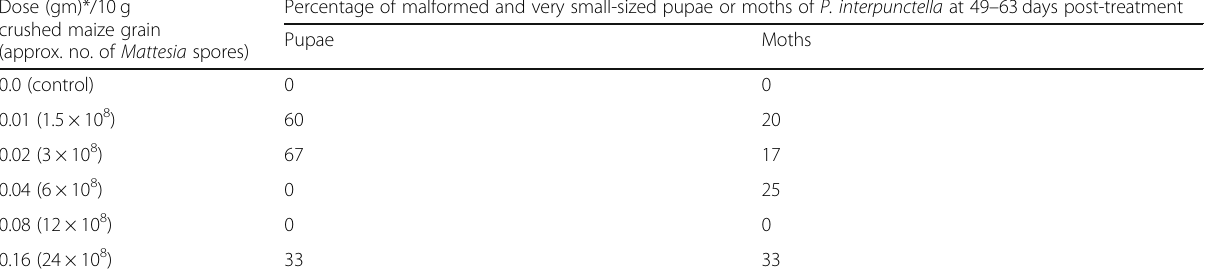
Table 7 Adverse effects of Mattesia infection on Plodia interpunctella survivors Dose (gm)*/10 g crushed maize grain (approx. no. of Mattesia spores)